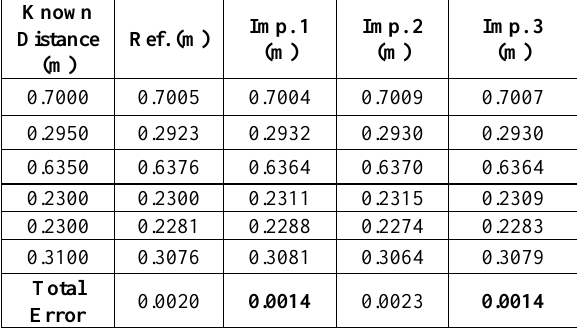
Table 4. Known and estimated